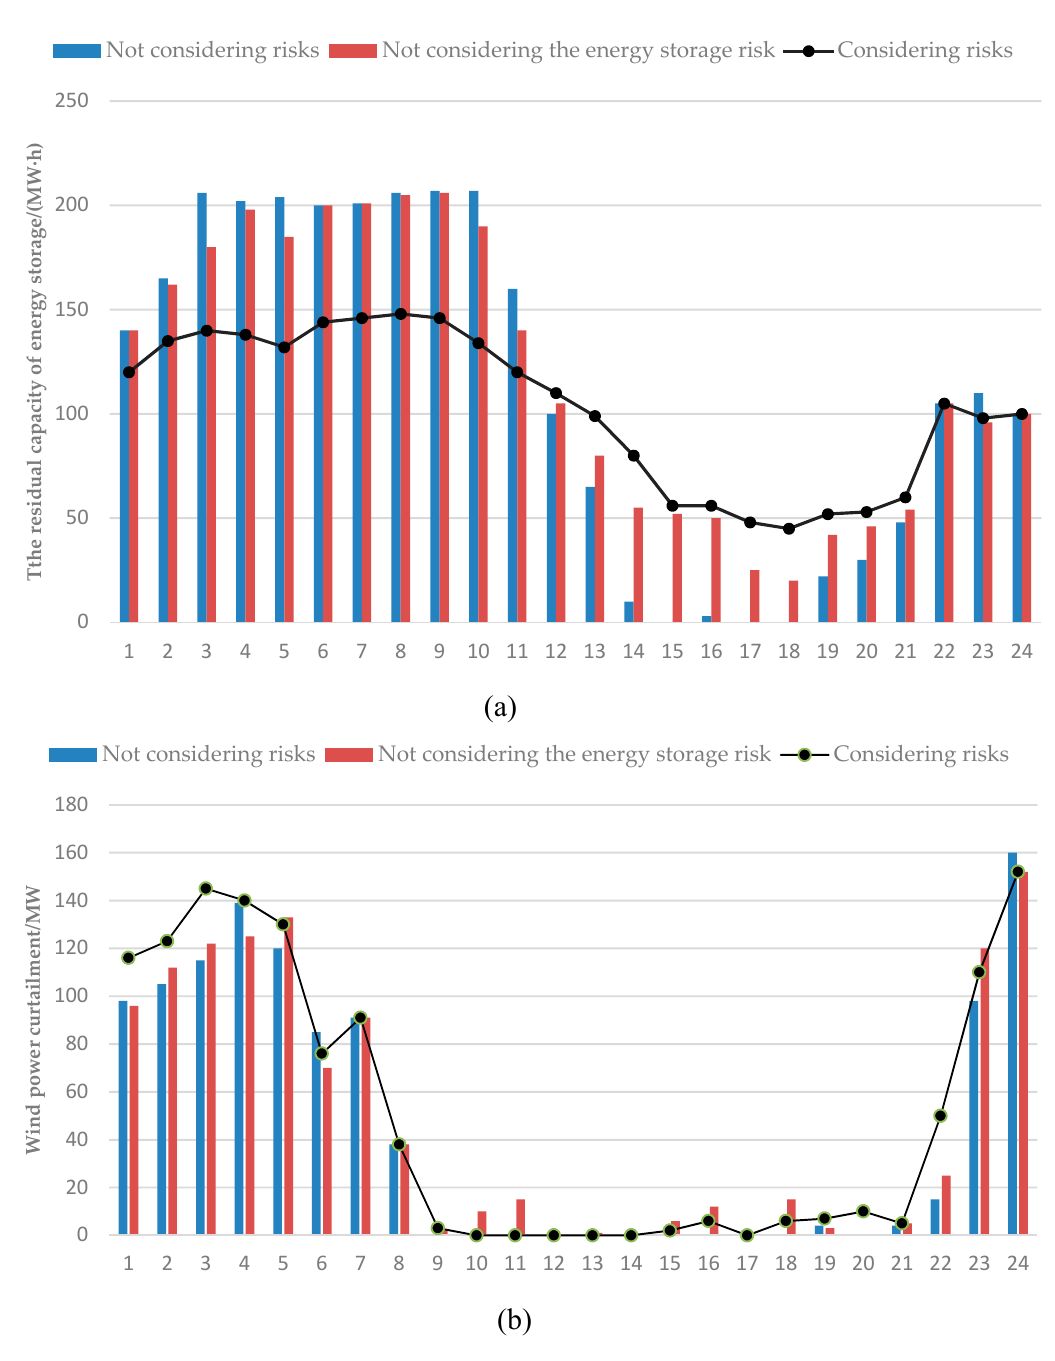
Figure 7. Scheduling results with different forecasting wind power.